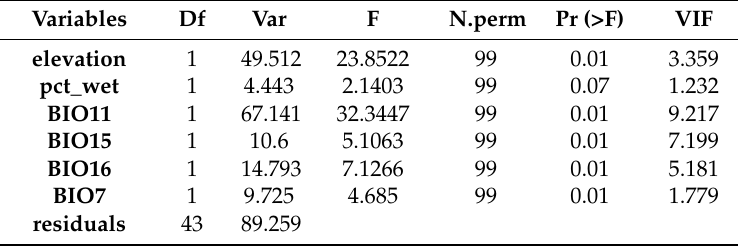
Table 4. Results of the statistical permutation test carried out on the predictor